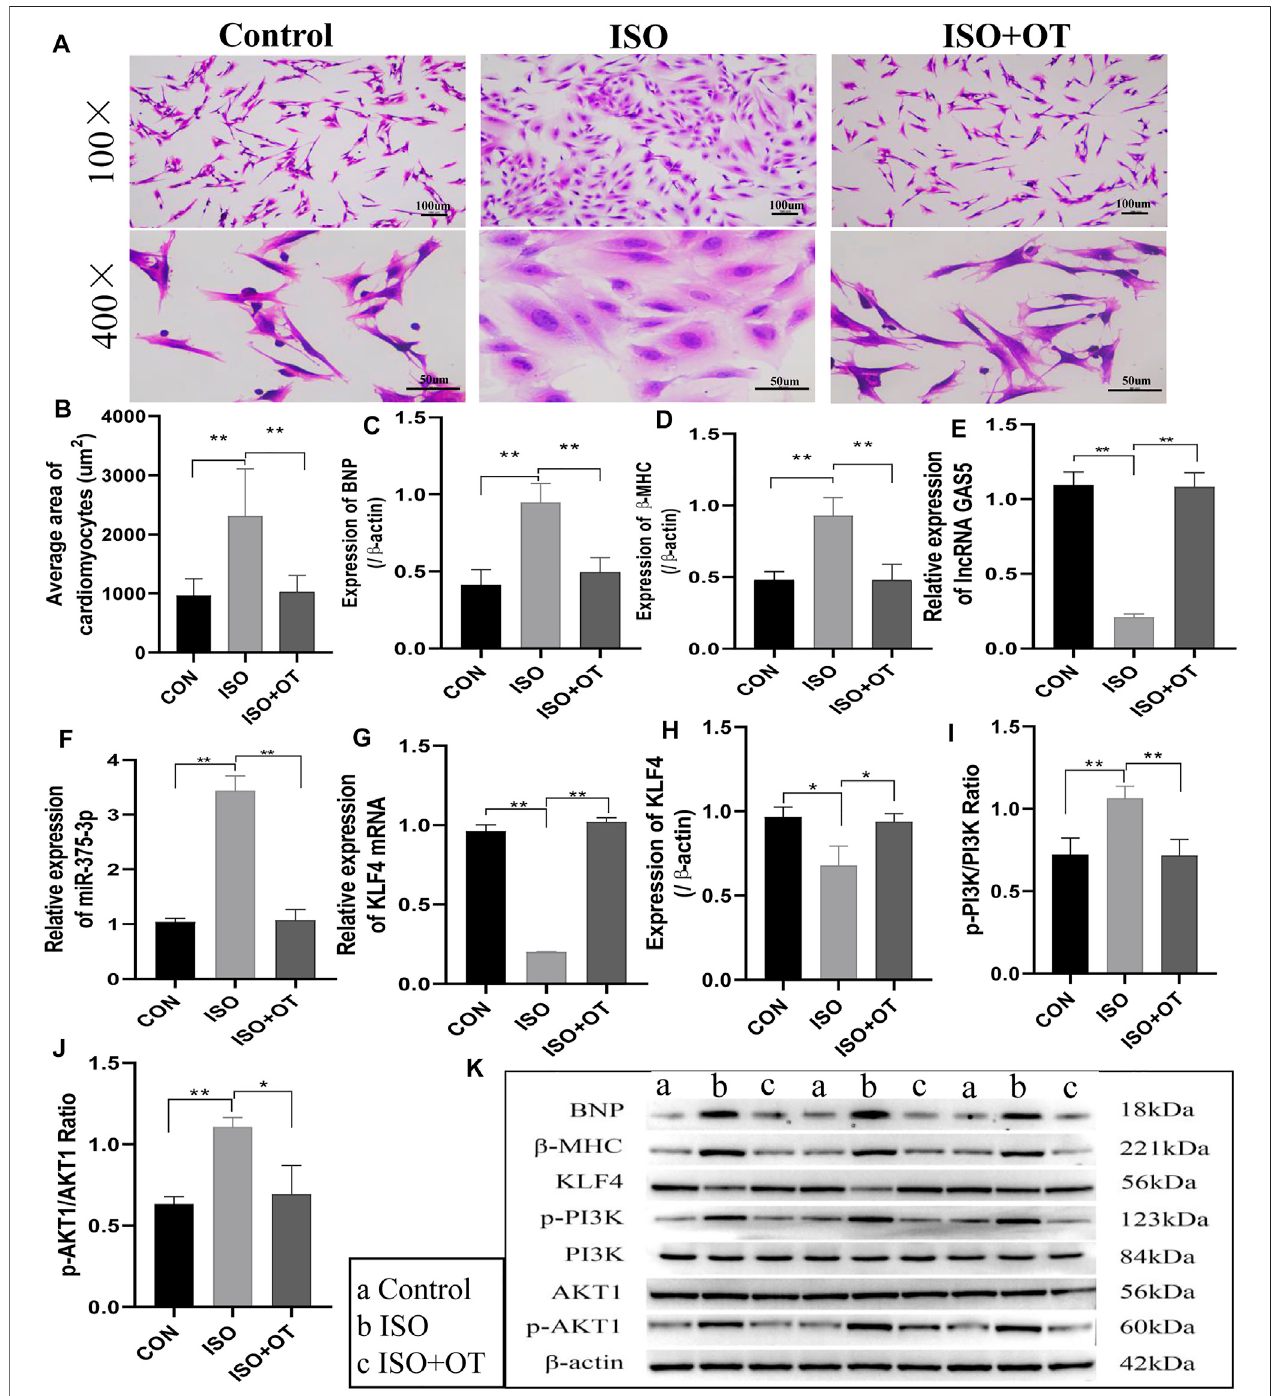
FIGURE 2 | Antihypertrophic effects of OT in vitro . Neonatal rat cardiomyocytes stimulated with ISO for 24 h in the presence or absence of OT. (A) The cell morphology was evaluated by H&E staining. (B) Statistical results of measurement of cell surface areas. (C,D) Effects of OT on the protein expressions of BNP and β -MHC. (E) Effects of OT on the expression of lncRNA GAS5. (F) Effects of OT on the expression of miR-375-3p. (G,H) Effects of OT on the mRNA and protein expressions of KLF4. (I) Effects of OT on the p-PI3K/PI3K ratio. (J) Effects of OT on the p-AKT1/AKT1 ratio. (K) Western blot images of BNP, β -MHC, KLF4, p-PI3K, PI3K, AKT1, p-AKT1, and β -actin levels. Data are shown as the mean ± sd of three independent experiments. *, p < 0.05; **, p < 0.01.